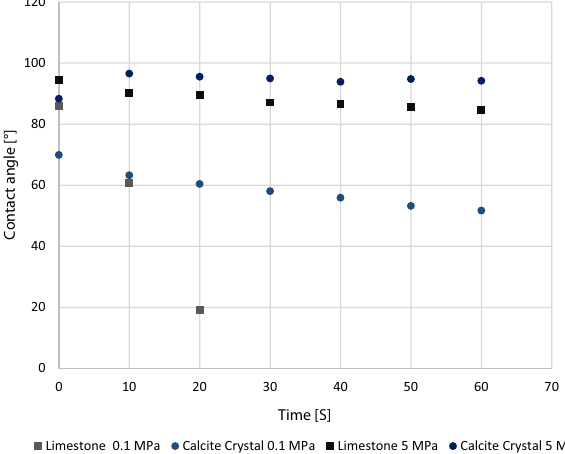
Fig. 11 Contact angle of a water drop on porous and non-porous calcium carbonate surfaces at atmospheric conditions and in com- pressed carbon dioxide, T = 40